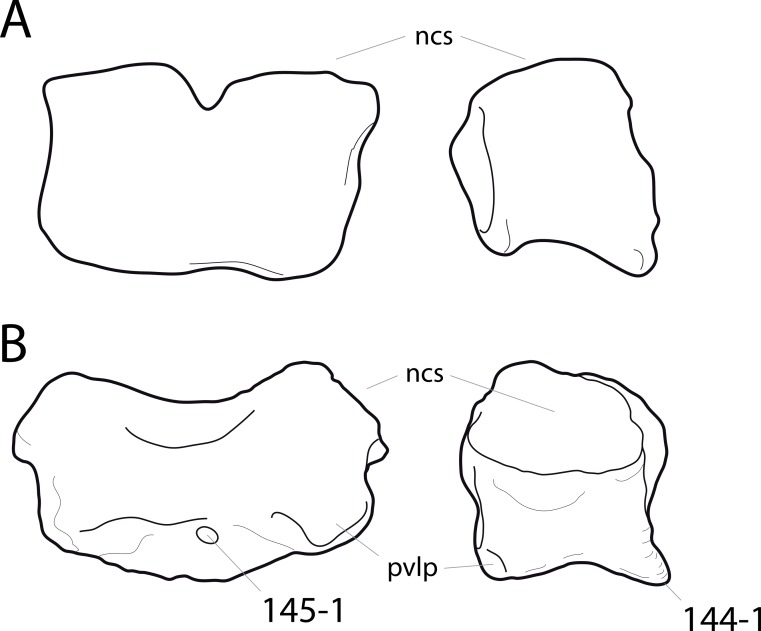
Neosauropod atlantes.Atlas of Camarasaurus sp. UUVP 10070 (A; modified from Madsen, McIntosh & Berman, 1995), and Galeamopus sp. AMNH 969 (B) in posterior (left) and right lateral view (right, A shows left side reversed). Note the distinct anteroventral lip characterizing diplodocids (B; C144-1), and the foramen between the posterior ventrolateral processes in AMNH 969 (B; C145-1). Abb.: ncs, neurocentral synchondrosis; pvlp, posterior ventrolateral process. Scaled to the same centrum height.